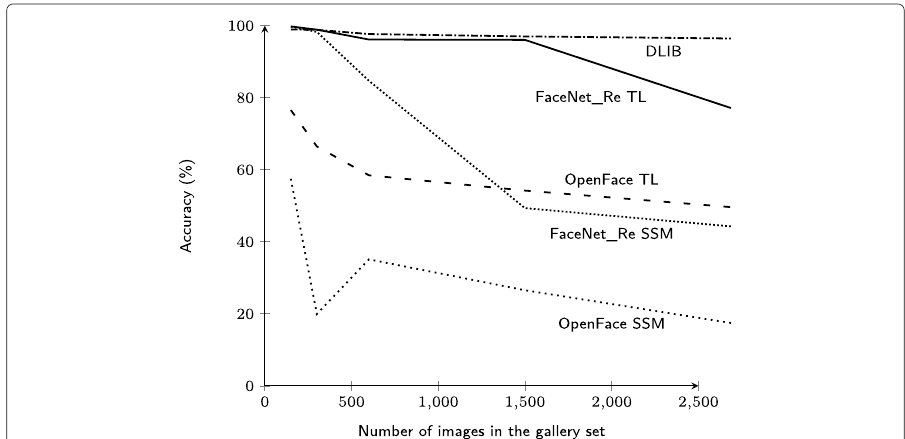
Fig. 9 Face recognition accuracy against the gallery size. SSM, subject-specific modeling; TL, template learning. The gallery contains three images per subject and ranges from 150 images to 2700 images, i.e., 50–900 subjects